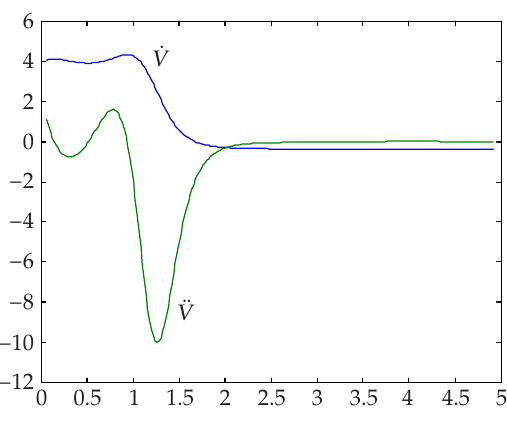
Figure 2.5 . First and second derivatives near a point of